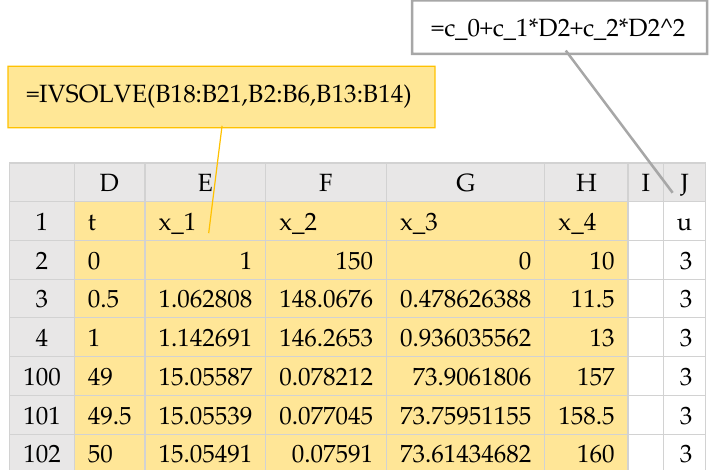
Figure 21 . Partial display of IVP (28)–(34) solution obtained by IVSOLVE formula (37), and generated values for the parametrized control of problem 3.4.